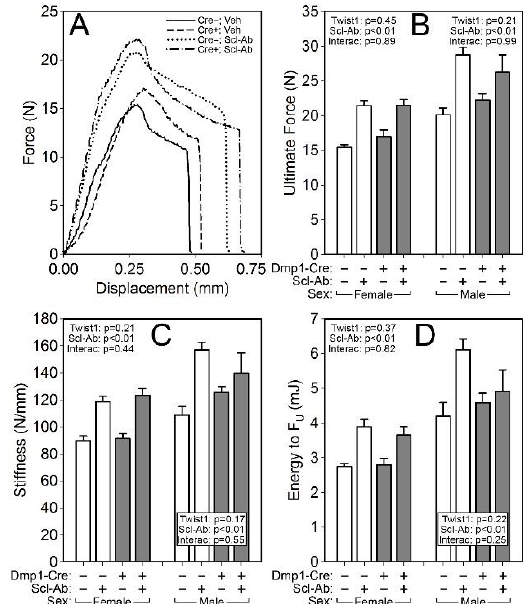
Figure 5. ( A ) Representative force-displacement curves from monotonic three-point bending tests to failure conducted on whole femora from female Cre-negative and 10kb Dmp1-Cre-positive Twist1 f/f mice at 16 wk of age, treated with or without sclerostin antibody (Scl-Ab) for 6 wk prior to sacrifice. Quantification of ( B ) ultimate force, ( C ) stiffness, and ( D ) energy to ultimate force revealed strong antibody effects in both Twist-replete and -deficient mice, but no effect of the Twist mutation alone was detected. Data were tested for significance using two-way ANOVA within sex, with Twist1 status and antibody as the main effects (plus interaction), which are reported in the corner or base of each sex grouping; n = 8–11/group.